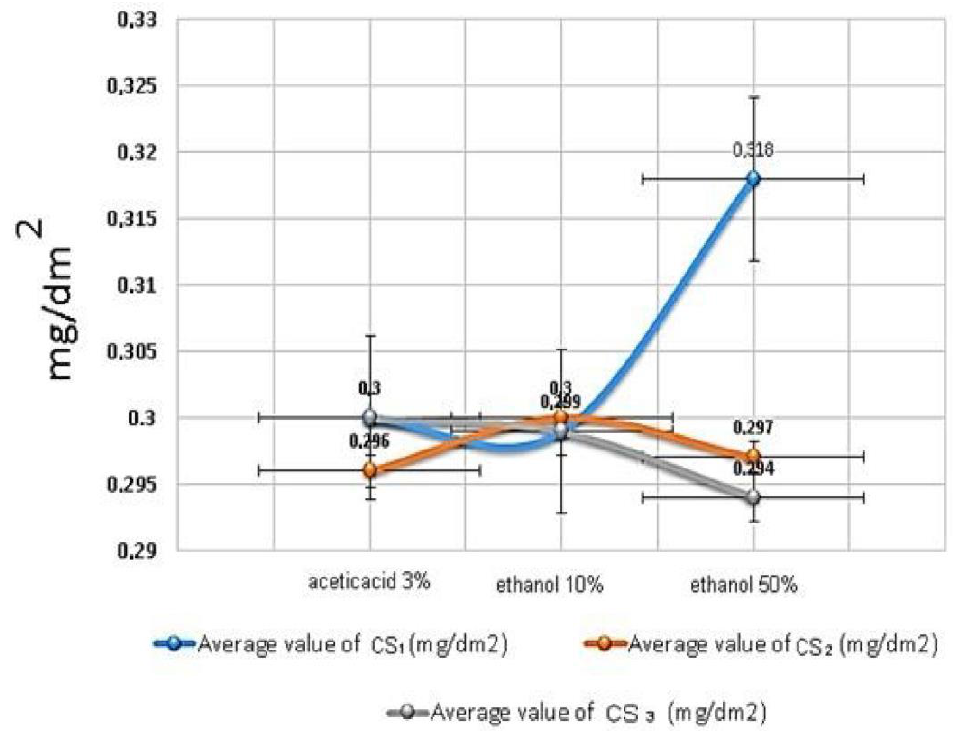
Figure 6. The migration analysis results of CS and CS silver nanofilms.